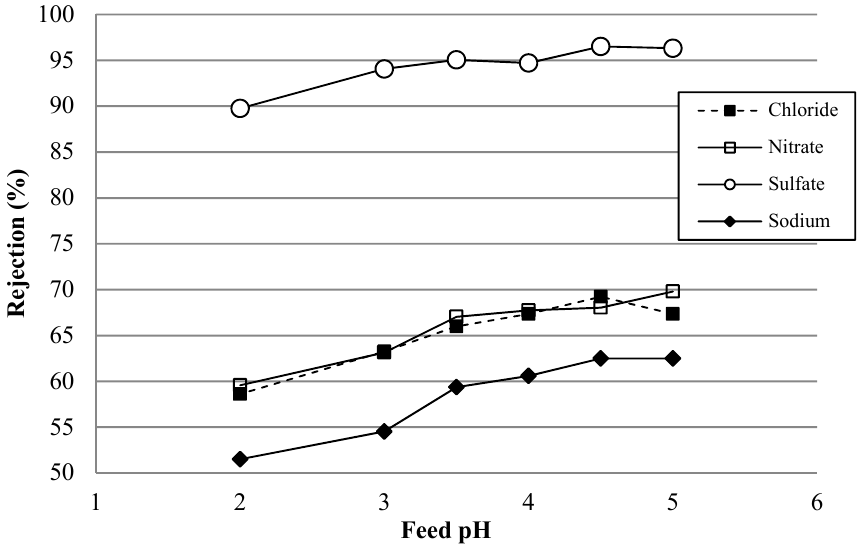
Figure 10. Apparent species rejection as a function of feed pH.